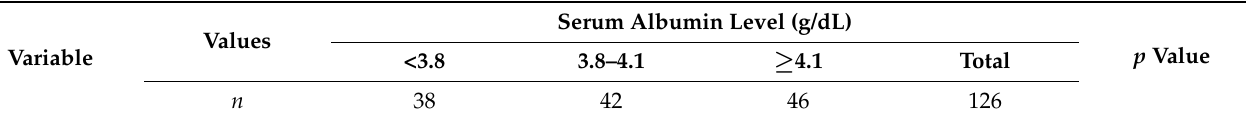
Table 2. Atrial fibrillation (AF) characteristics (at the baseline) according to serum albumin (SA) level